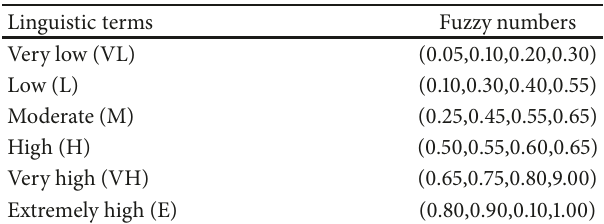
Table 3: Linguistic terms for the effects of risks on the different energy